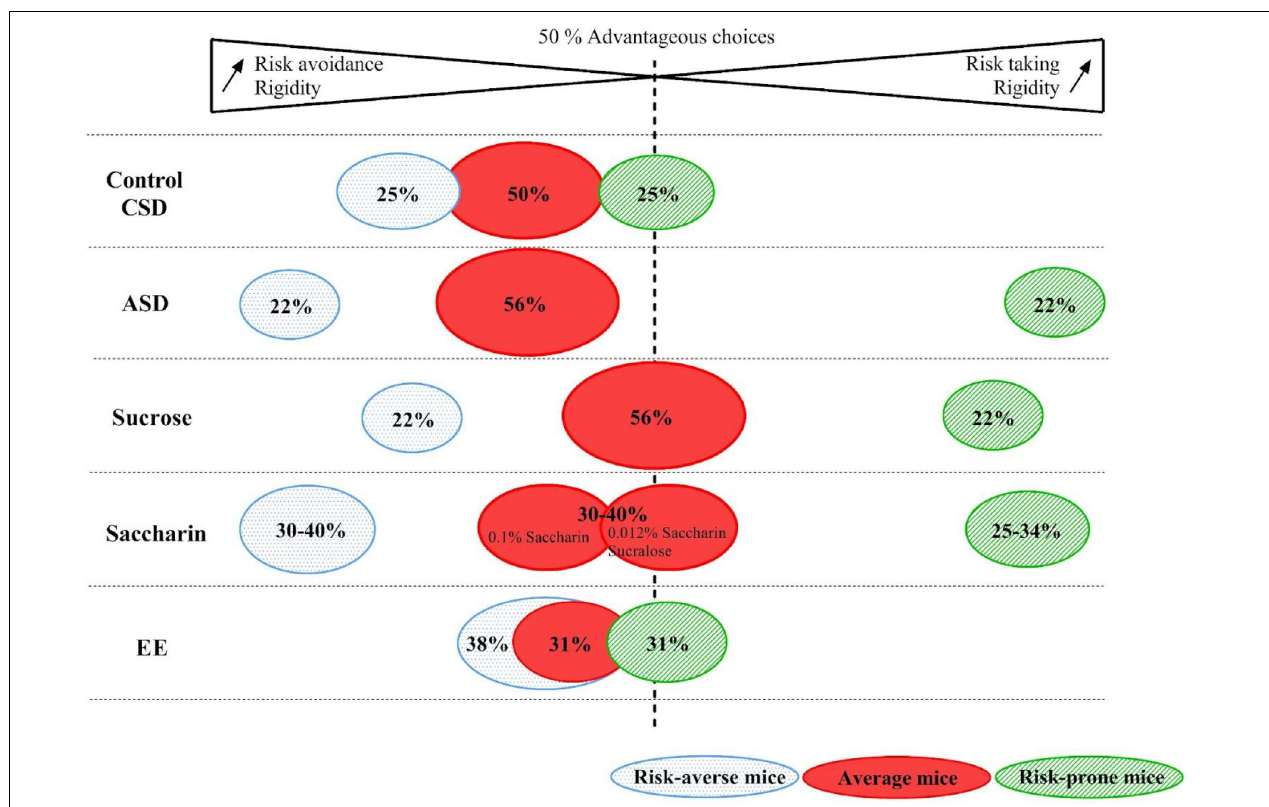
FIGURE 8 | Representation of the percentage of risk-averse, average and risk-prone mice in the control, Chronic Sleep Debt (CSD), Acute Sleep Debt (ASD), sucrose or saccharin consumption and Enriched Environment (EE) conditions. Gradients of rigidity as well as risk taking or risk avoidance are represented by the